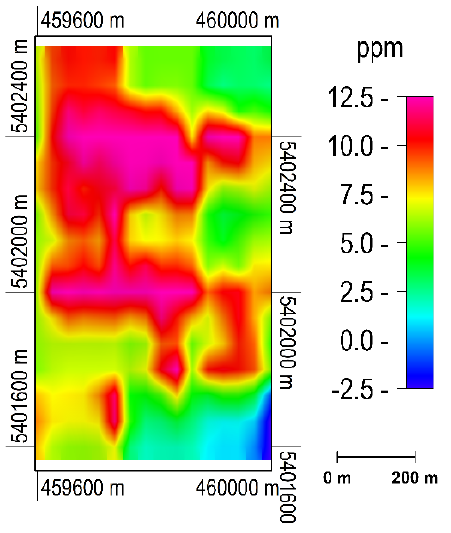
Figure 1. Reid–Mahaffy airborne geophysical test site location (from [37]).